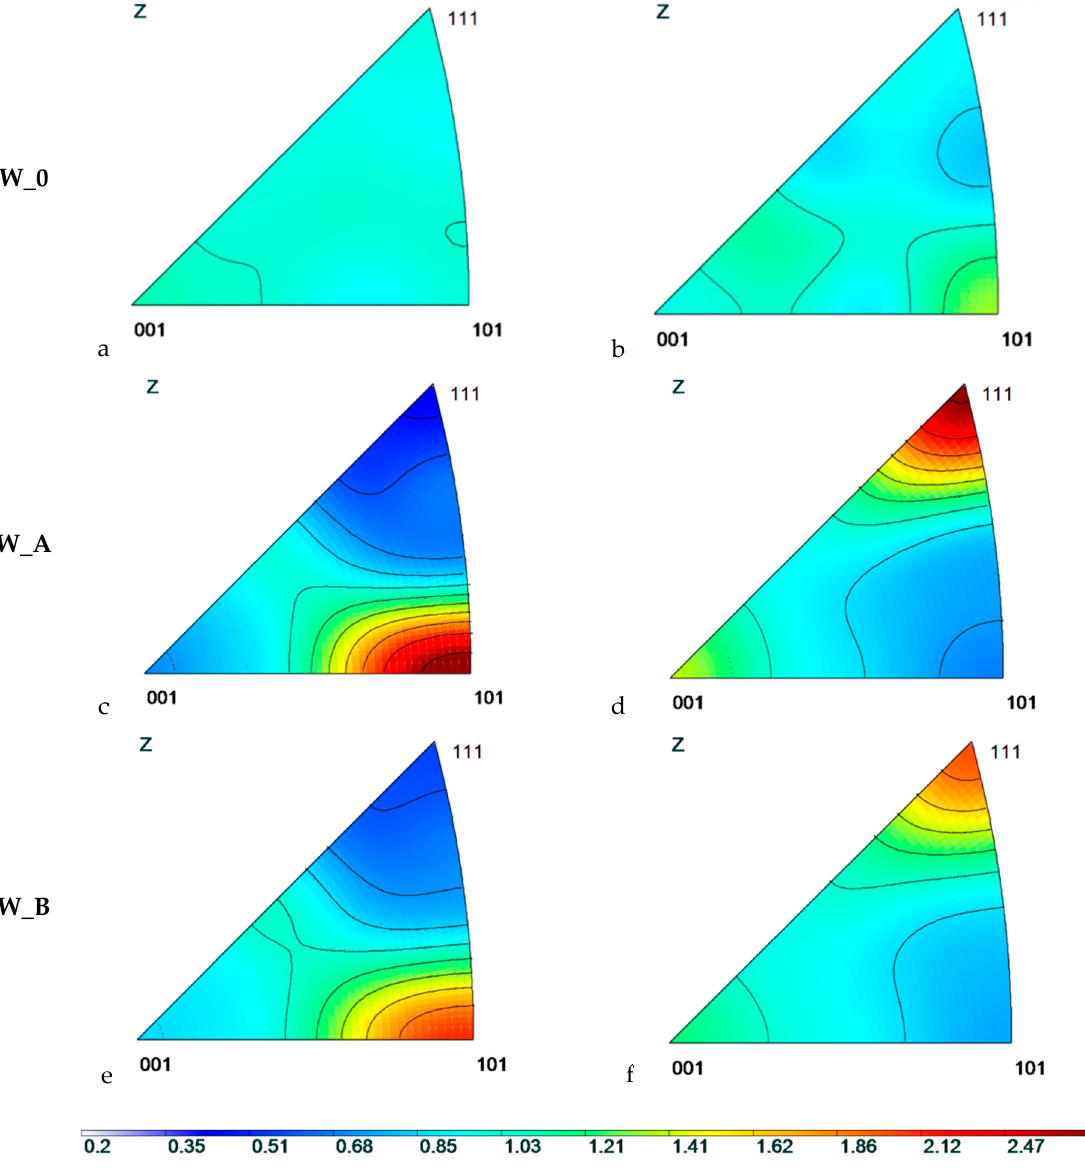
Figure 5. The inverse pole figures for all the samples (marked on the left: W_0 ( a , b ); W_A ( c , d ); W_B ( e , f )) and both phases W-B2, NiCo2W (marked on the top: B2 ( a , c , e ); NiCo2W ( b , d , f )) for the direction along the sample-bar axis ( z or direction 1). The intensity scale is identical for all graphs.